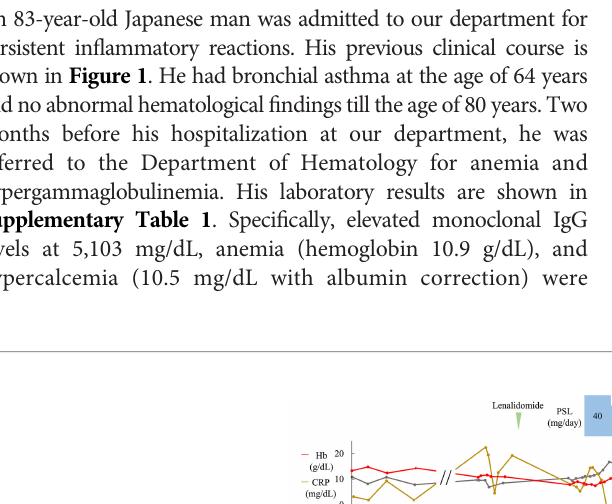
FIGURE 1 | Clinical course of the patient. CRP, C-reactive protein; Hb, hemoglobin; IgG, immunoglobulin G; MCV, mean corpuscular volume; MM, multiple myeloma; PSL, prednisolone; RP, relapsing polychondritis; TP, total